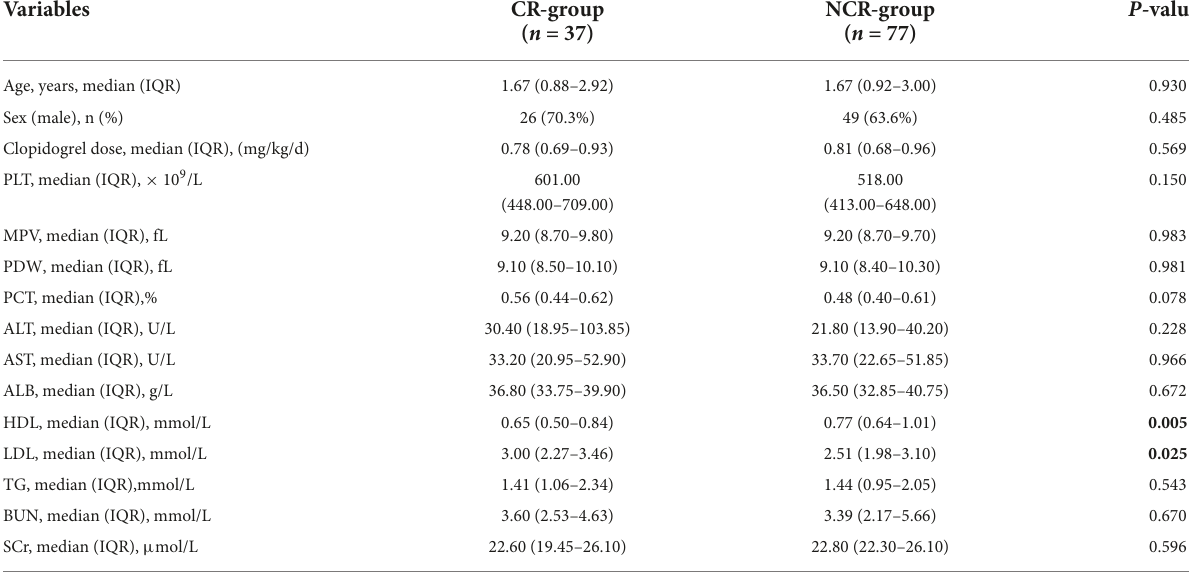
TABLE 3 Comparison of laboratory indicators in CR group and NCR group.